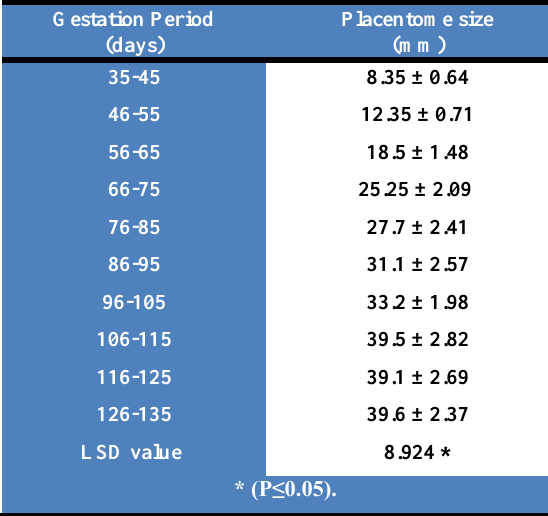
Table, 1: Ultrasonic measurement of placentome diameter at different Gestational age in